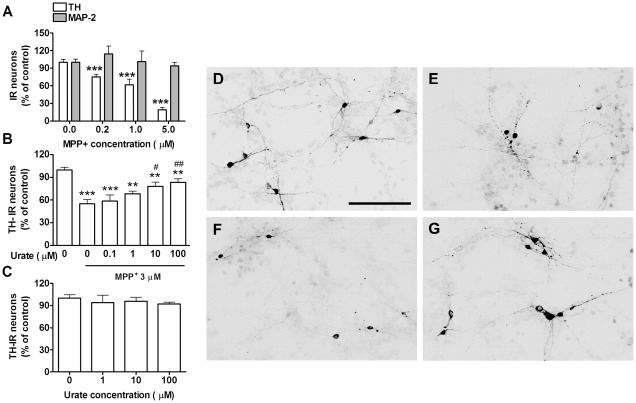
Urate's protective effect on dopaminergic neurons in neuron-enriched cultures.
A) MPP+ concentration-dependent effect on dopaminergic and total neuron viability expressed respectively as percentage of TH- and MAP-2-IR cell number in comparison to control cultures (n = 5). B) Urate concentration-dependent effect on TH-IR cell number in 3 µM MPP+-treated cultures (n = 7). C) Lack of urate effect at any concentration on TH-IR neuron number in control (MPP+-untreated) cultures (n = 5). Photomicrographs show TH-IR neurons in D) control cultures, E) MPP+/0 urate-treated cultures, F) MPP+/0.1 urate-treated cultures and G) MPP+/100 µM urate-treated cultures. Scale bar = 50 µm. One-way ANOVA followed by Newman-Keuls test: **P<0.01, ***P<0.001 vs 0 MPP+ value; #
P<0.05, ##
P<0.01 vs MPP+/0 urate value.